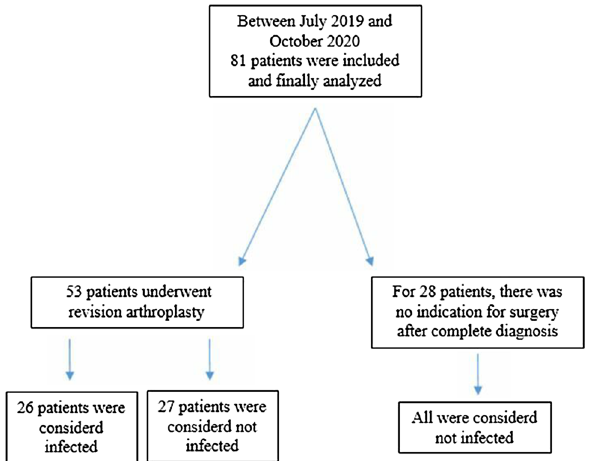
Figure 1. STROBE (strengthening the reporting of observational studies in epidemiology) diagram of patients shows the study